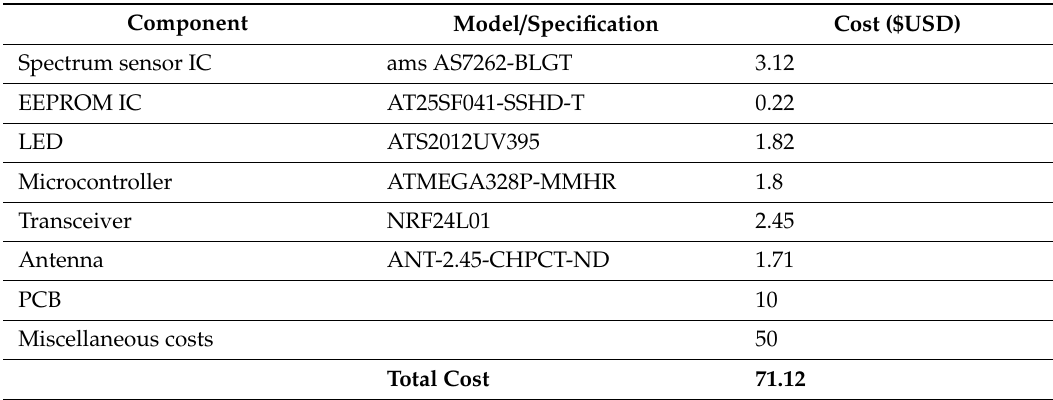
Table 1. Cost breakdown of the proposed capsule